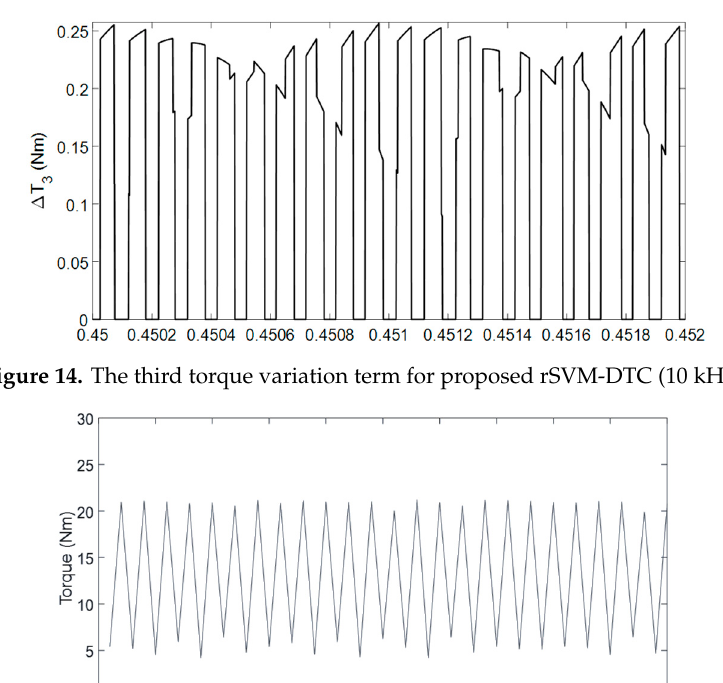
Figure 15. Influence of the third torque variation on torque output on cSVM-DTC1.